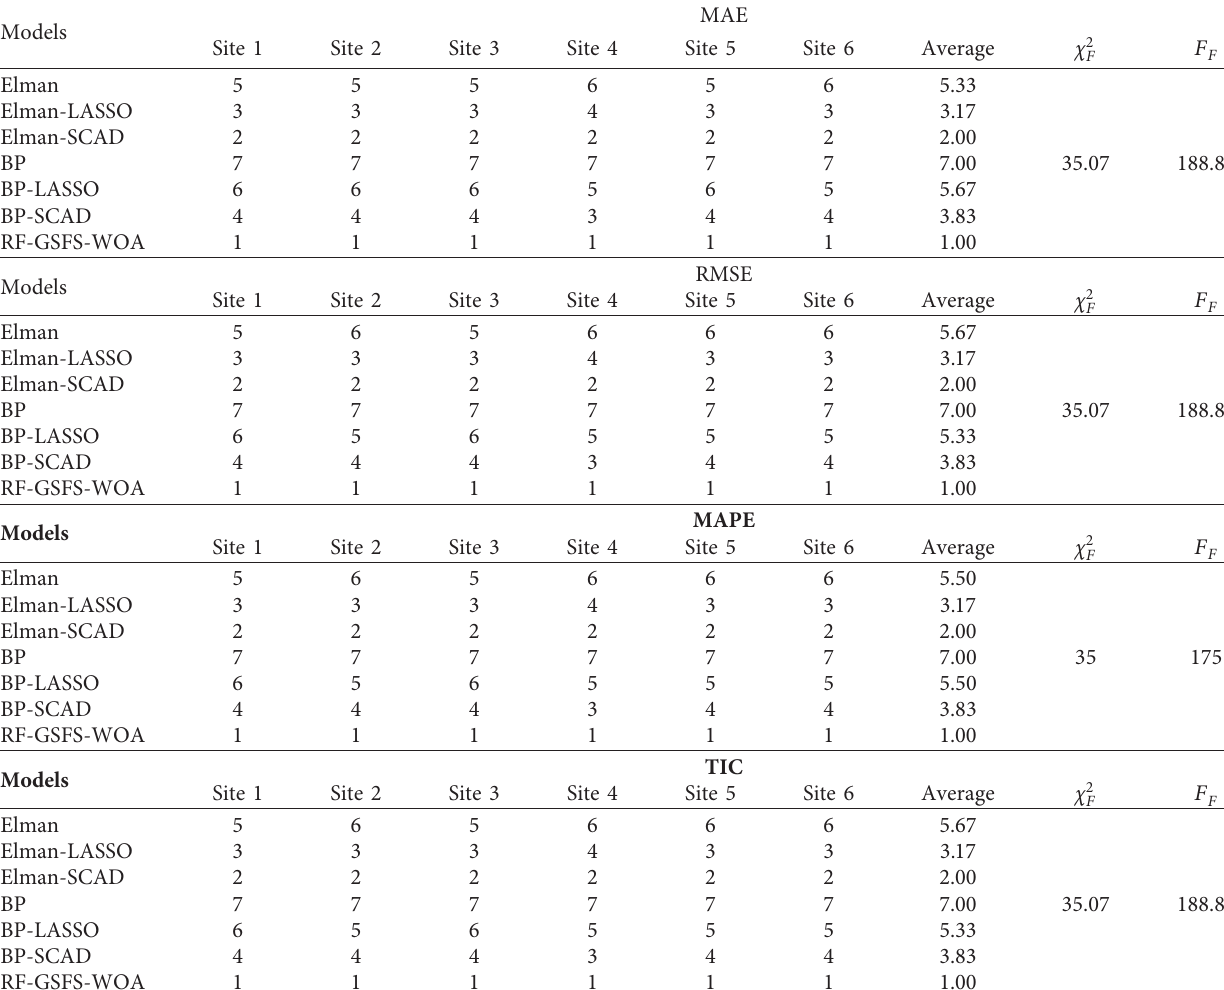
Figure 8: Average values of MAPE and RMSE for four seasons at six sites. Table 6: Results of Friedman test for all forecasting